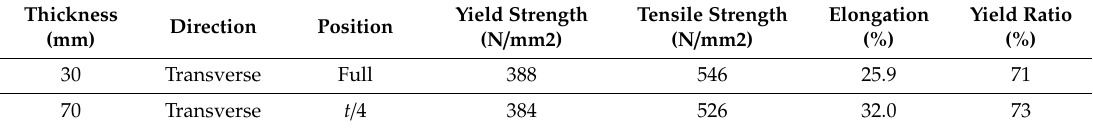
Table 5. Tensile test results depending on thickness and position of the SN 490C plates.